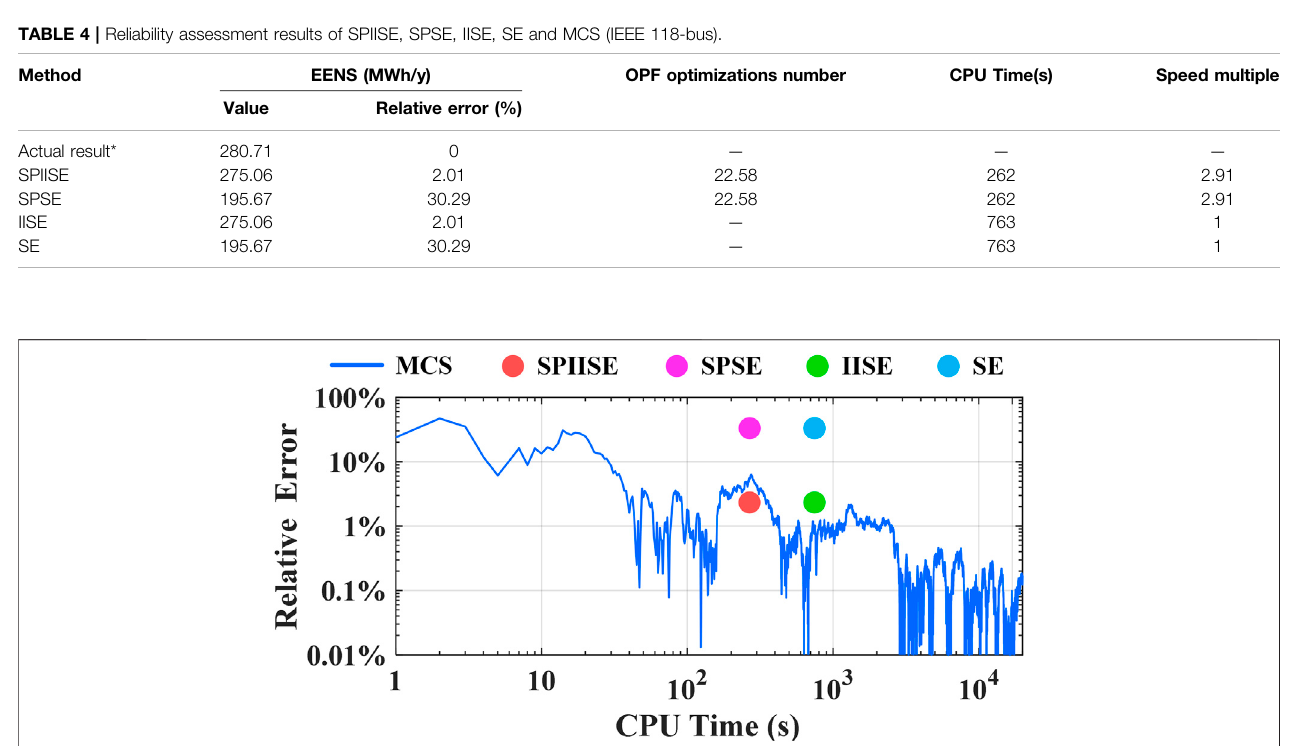
FIGURE 11 | Comparisons of computation ef fi ciencies of fi ve methods (IEEE